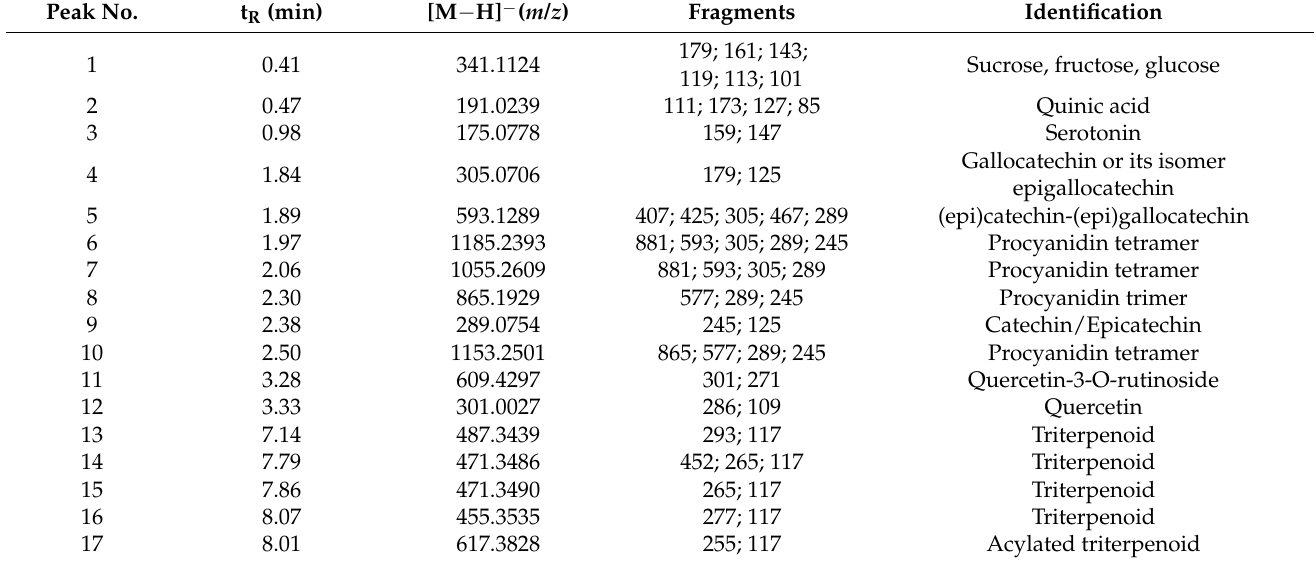
Figure 1. PAC content in extract isolated by 50% EtOH or water from eight SBT cultivars’ twigs. For the extracts obtained using the same solvent, the PAC values were close to each other for all SBT cultivars growing on the same plantation, which indicates the similarity of their ability to synthesize secondary metabolites. SBT extracts contain not only oligomeric PACs, but also other polyphenolic compounds such as quercetin (16), quinic acid (2), and gallocatechin or its isomer epigallocatechin (4), which have excellent documented anti-bacterial activity against Staphylococcus aureus, Bacillus subtilis , and Escherichia coli [35,36]. Polar triterpenoids are also present in the composition of the extracts, which for the extracts from the other plants, have shown strong anti-inflammatory effects [37]. The list of identified components is shown in Table 1, and the structures of some of the identified components in Figure 2. Table 1. Tentatively identified components in tested SBT extracts. Peak